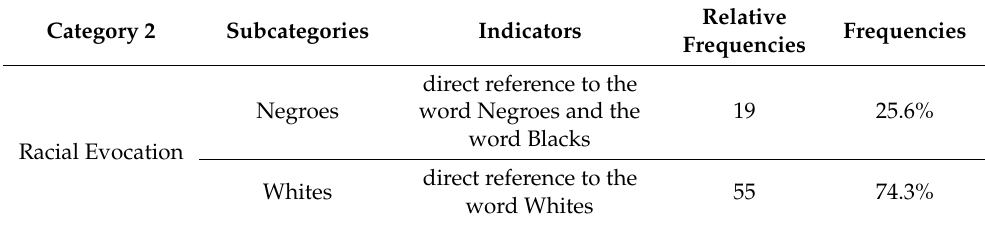
Table 3. Absolute and relative frequencies for the category “Racial